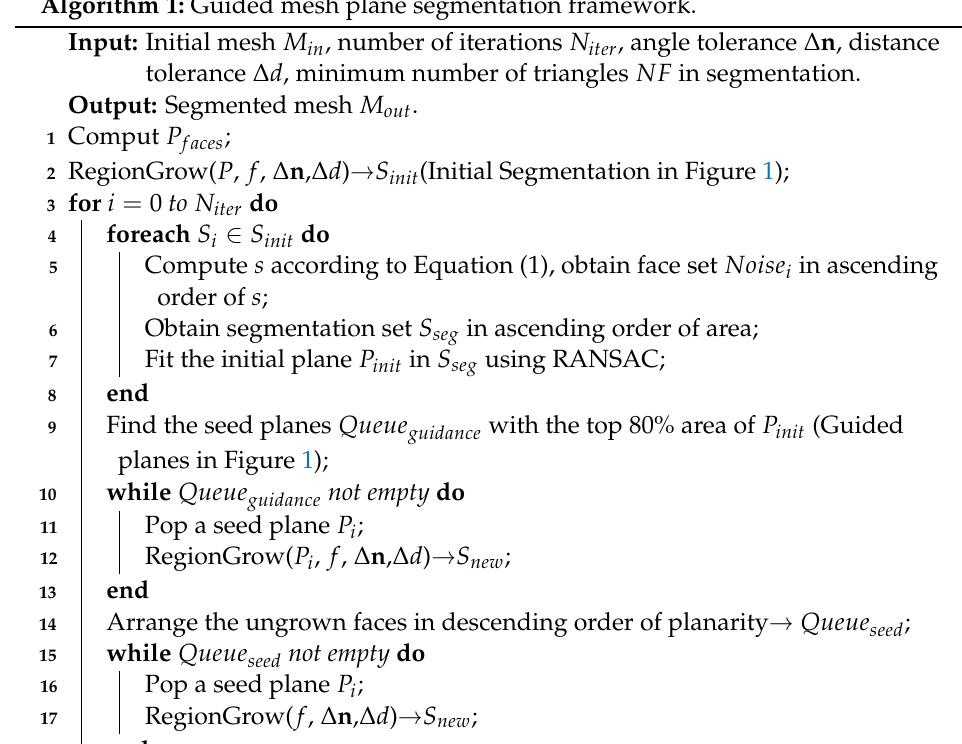
Algorithm 1: Guided mesh plane segmentation